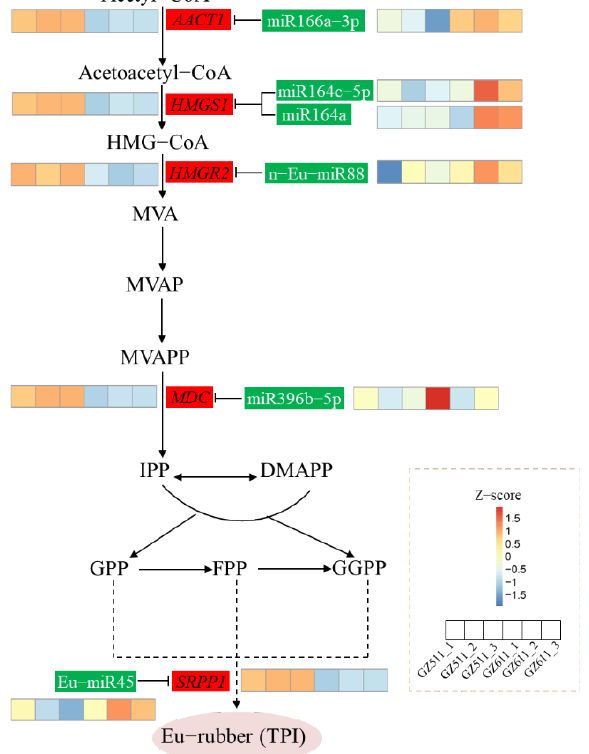
Figure 5. The differentially expressed miRNA − target gene pairs involved in Eu − rubber biosynthesis. Red and blue indicate up − and downregulated miRNAs and target genes under the comparison of GZ511 vs. GZ611, respectively. Detailed information about differentially expressed target genes is pre- sented in Table S8. AACT, acetyl − CoA C − acetyltransferase; HMGS, hydroxymethylglutaryl − CoA synthase; HMGR, hydroxymethylglutaryl − CoA reductase; MDC, mevalonate pyrophosphate decar- boxylase; SRPP, small rubber particle protein; HMG − CoA, 3 − hydroxy − 3 − methylglutaryl − CoA; MVA, mevalonate; MVAP, mevalonate − 5 − phosphate; MVAPP, mevalonate − 5 − diphosphate; IPP, isopentenyl diphosphate; DMAPP, dimethylallyl diphosphate; GPP, geranyl diphosphate; FPP, farne- syl diphosphate; GGPP, geranylgeranyl